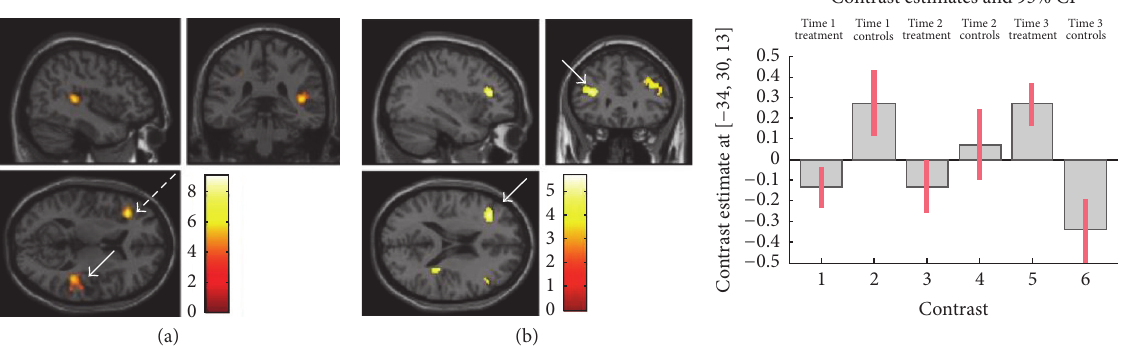
Figure 2: Increased activations in treatment group relative to controls at follow-up. (a) Increased activation in treatment group in right parietal region (white arrow, 𝑝 < 0.012 FWE corrected ) and left prefrontal region (dashed arrow, 𝑝 < 0.001 FWE corrected ). (b) Bilateral frontal gyrus activation in treatment group relative to controls. Left MFG activation (arrow) significant at 𝑝 ≤ 0.042 FWE corrected at cluster level ( 𝑘 = 152